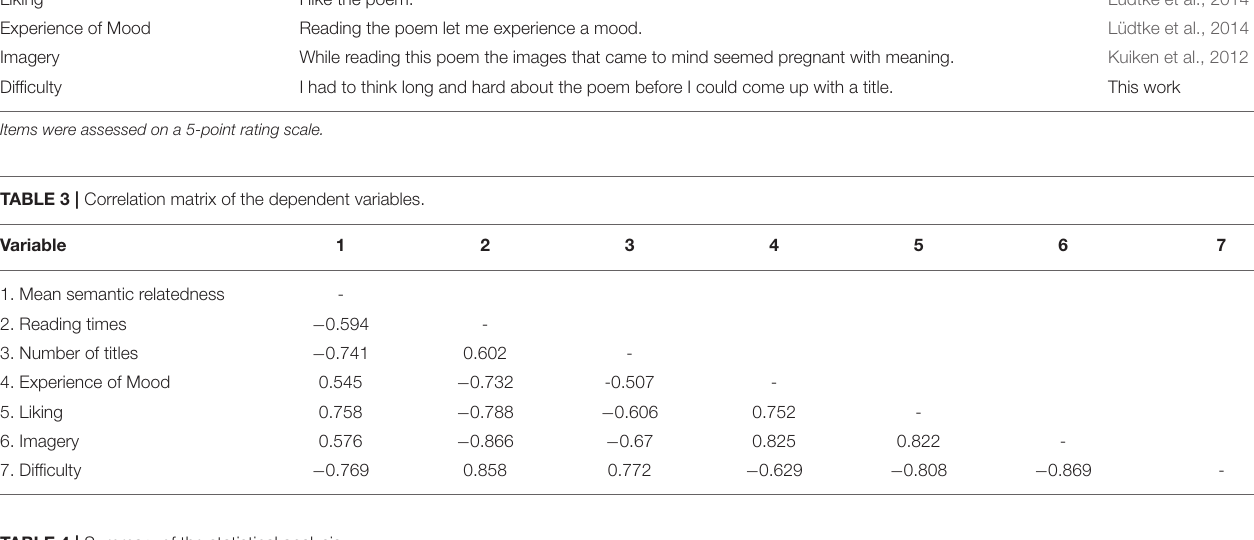
TABLE 4 | Summary of the statistical analysis.